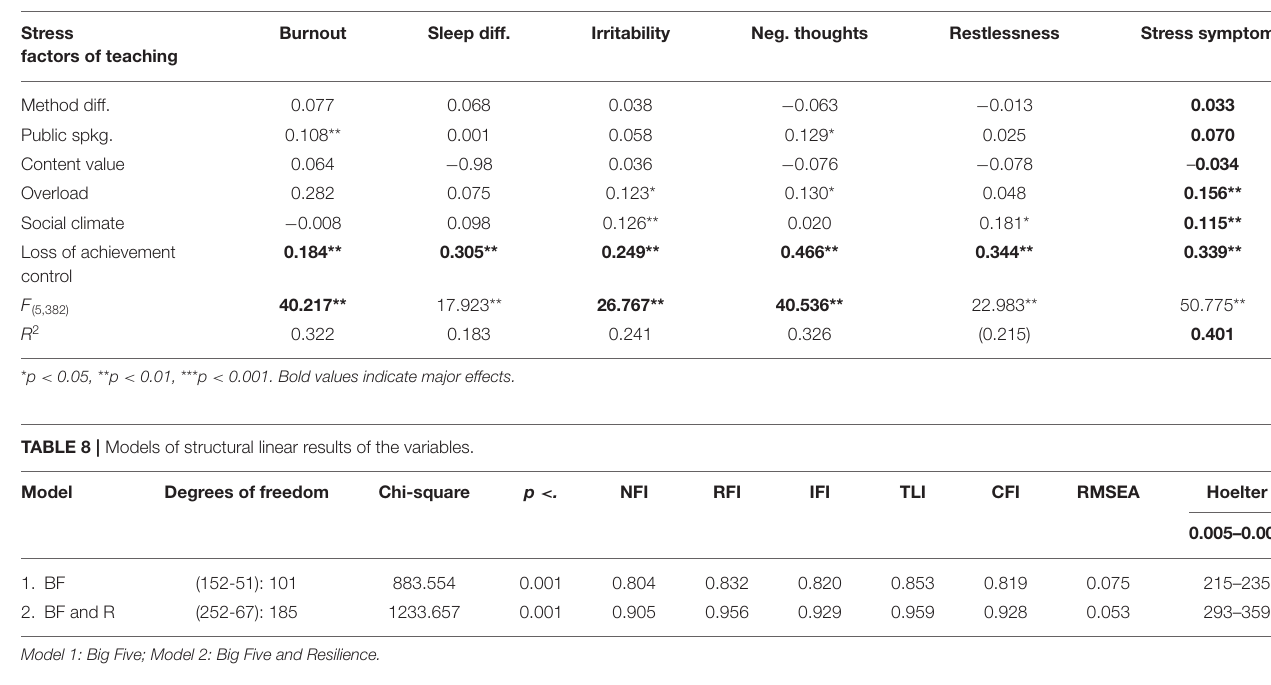
TABLE 7 | Multiple regression between factor of stress, and symptoms of academic stress ( n = 405). Stress factors of teaching Method diff. Public spkg.